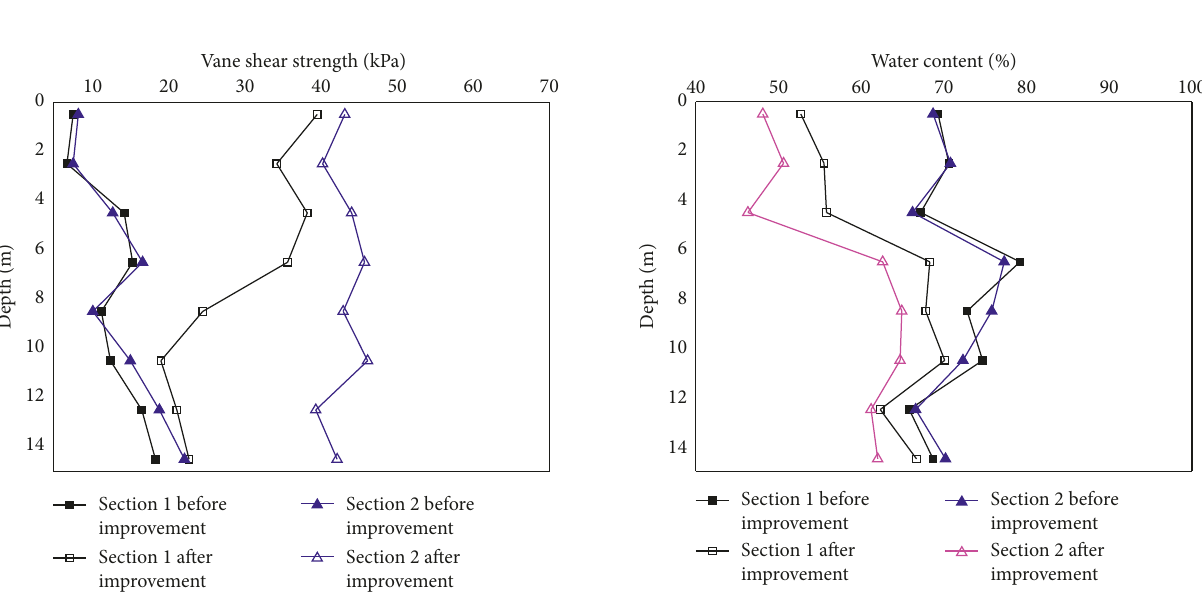
Figure 14: Vane shear strengths plotted as functions of depth for sections 1 and 2.